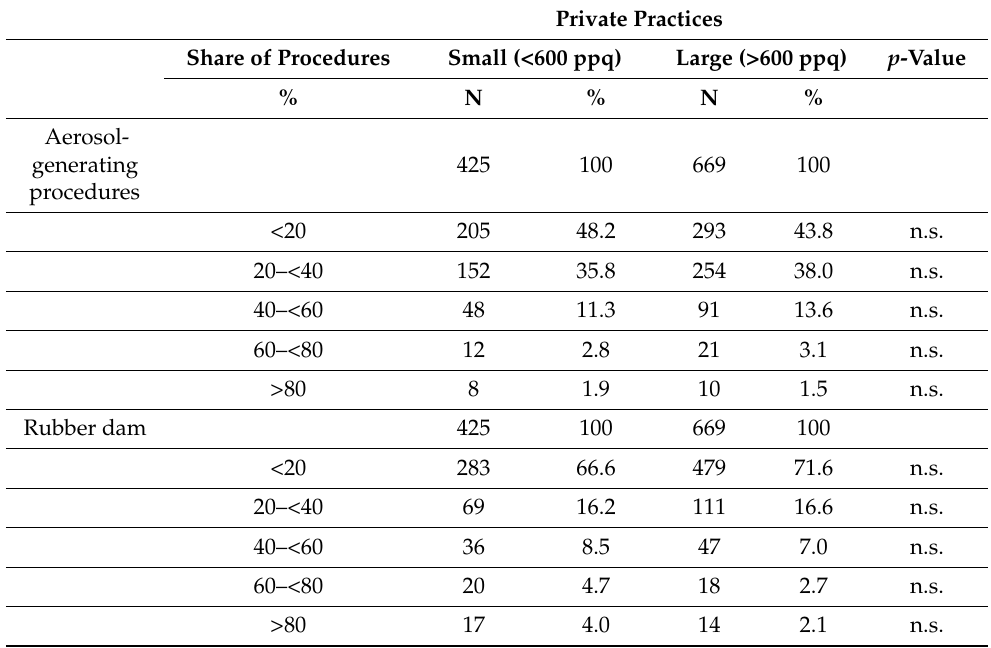
Table 5. Share of aerosol-generating procedures and use of rubber dam.